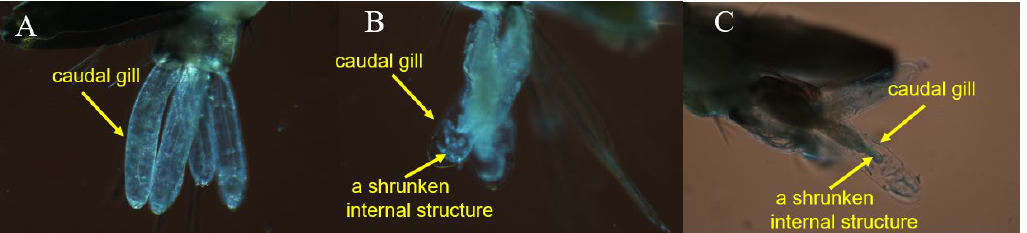
Figure 7. Observation of the larval caudal gill: ( A ) the negative control group; ( B ) the SOP-2q treated group; ( C ) the SOP-2r treated group.